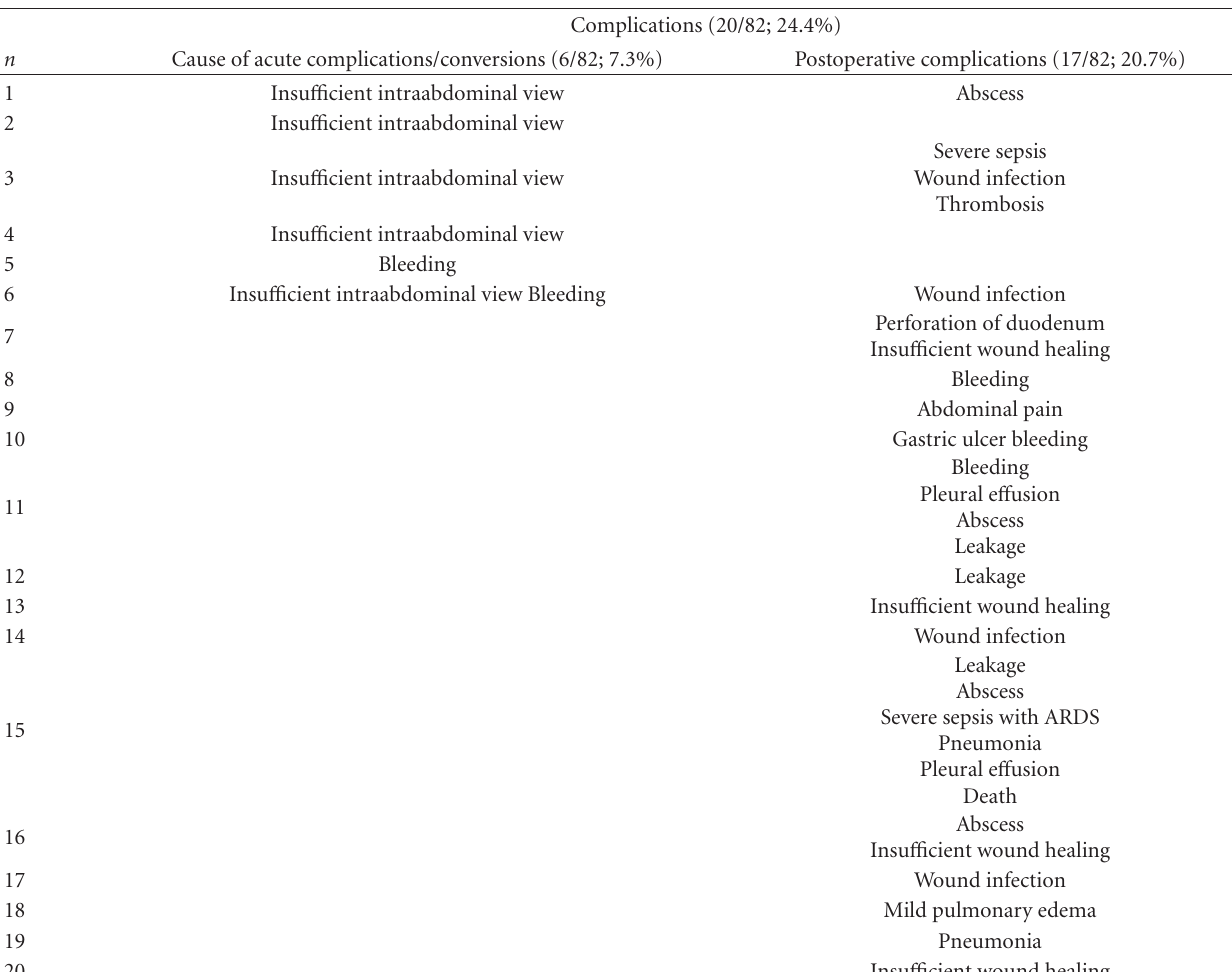
Table 3: Acute and postoperative complications.